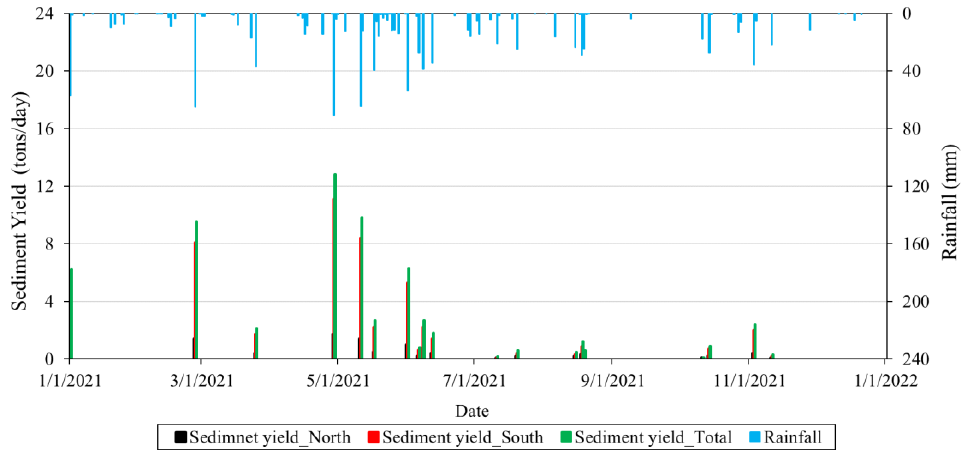
Figure 15. Sediment yield at the Wilson Creek bridge site due to overland erosion in construction areas and daily rainfall records from the Frisco station.